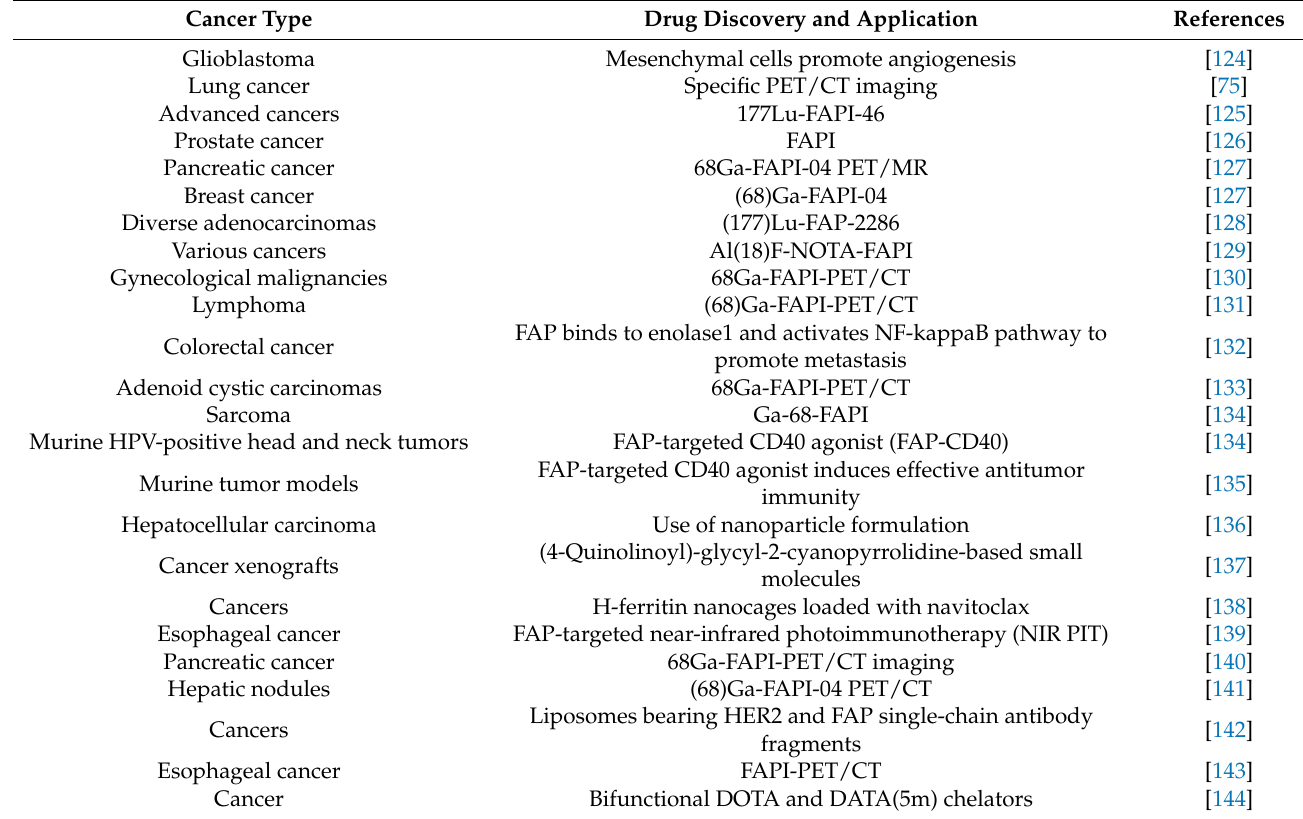
Table 2. Recently emerged CAF-targeting FAP